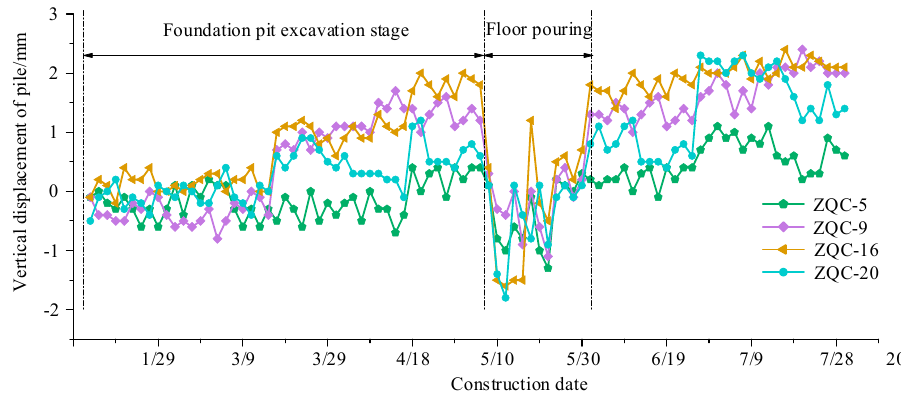
Figure 5. Time − history curve of the vertical displacement of the pile top of the retaining pile. The measured horizontal displacement data of the four direction measuring points ZQS-3, ZQS-7, ZQS-17 and ZQS-20 of the retaining pile are selected for analysis, as shown